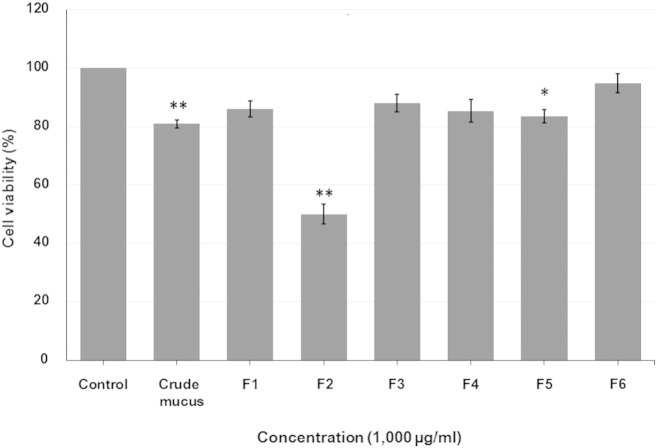
Percentages of the MCF-7 cell viability after 72 h treatment with A. fulica crude mucus and six HPLC-separated fractions (F1, F2, F3, F4, F5 and F6) at the concentration of 1000 μg/ml. The cell viability was measured by the MTT assay. Control was the untreated cells. Error bars represented the SEM, * and ** represented levels of significance at p < 0.05 and p < 0.01.